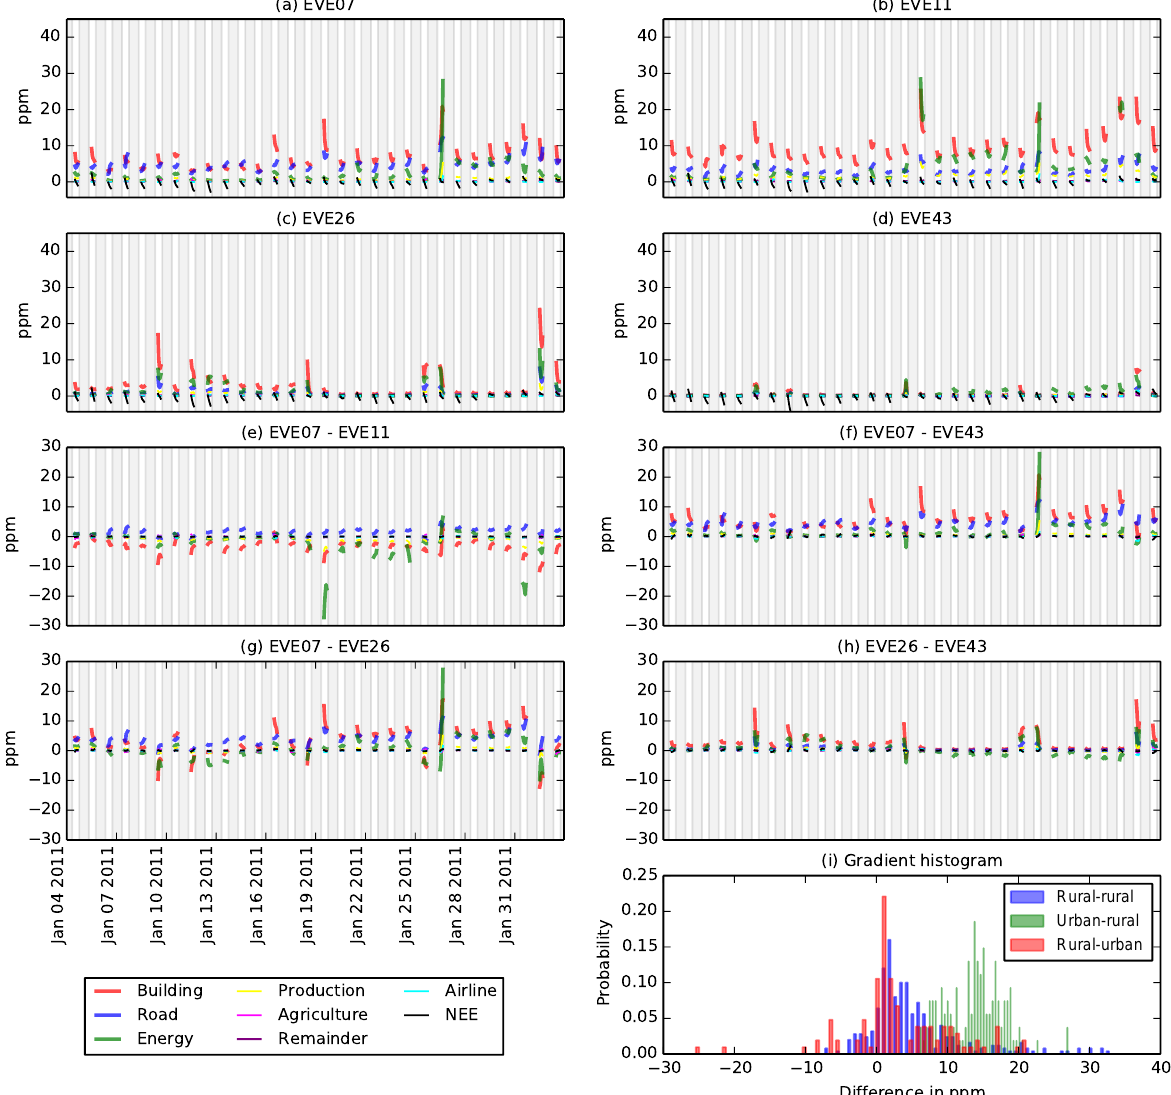
Figure 7. (a–d) CO 2 mixing ratio series of sectoral CHIMERE simulations at four selected stations of the R network (see Figs. 4 and 6c). EVE07 and EVE11 are urban sites and EVE26 and EVE43 are rural sites but close to large point emissions. The shadow marks out the nighttime. (e–h) The time series of the difference in model simulations sampled at several site pairs among the four sites. (i) The histogram of afternoon concentration gradients following the data selection procedure detailed in Sect. 2.4.3 for all the 10 stations of the R network. These histograms are grouped according to the type of downwind and upwind